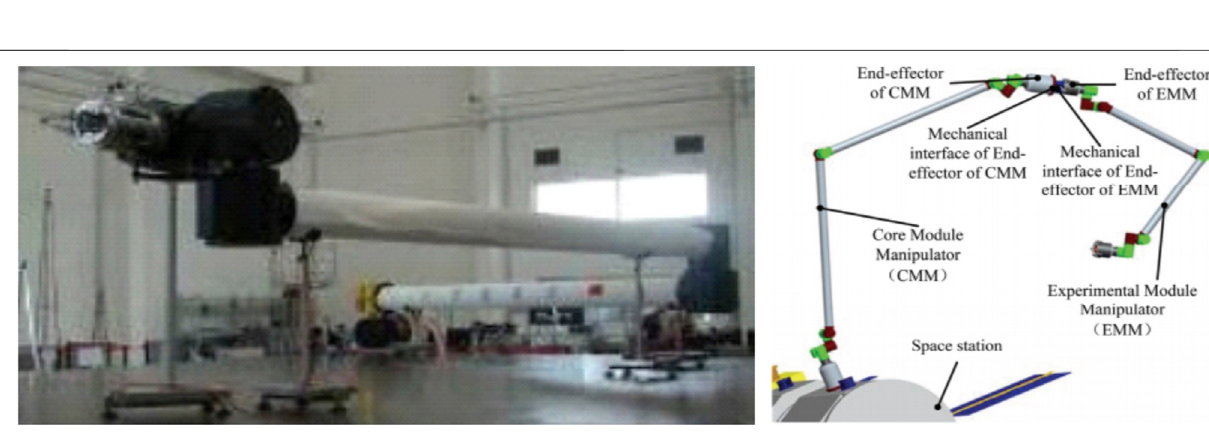
Frontiers in Robotics and AI |